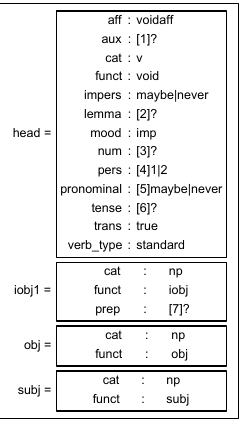
Frigram: a French Interaction Grammar